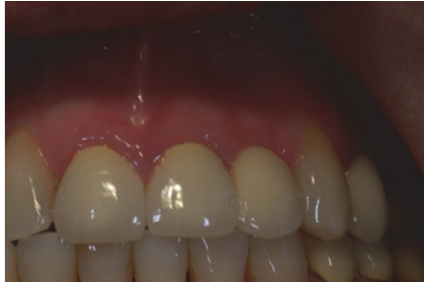
Figure 3: Following the sectioning of the cantilever bridge.